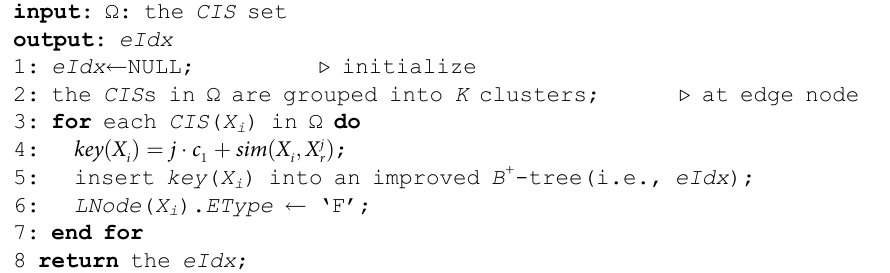
Algorithm 4 eIndex construction ( O )